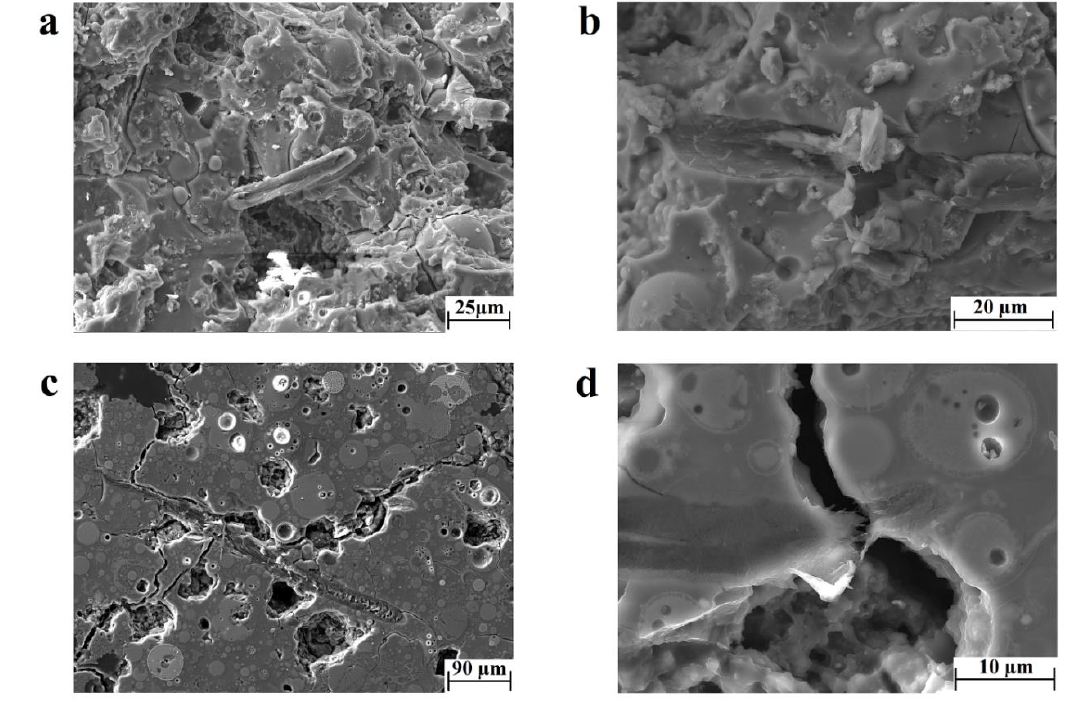
Figure 5. Fracture and polished surface observations of the microstructure of the geopolymer matrix composite through SEM images of ( a ) fiber pull-out and ( b ) negative site of a delaminated fiber, ( c ) crack-bridging, and ( d ) fiber